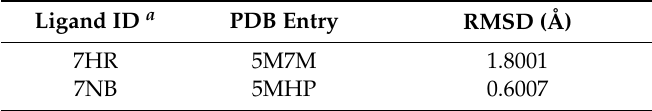
Figure 4. Binding modes of 7HR (yellow) ( A ) and 7NB (yellow) ( B ) in the active site of ATX. Ligands complexed with their receptors are also shown for comparison, 7HR and 7NB indicated in green stick form. Table 3. The crystal ATX inhibitors’ RMSD values between their docked postures and crystal